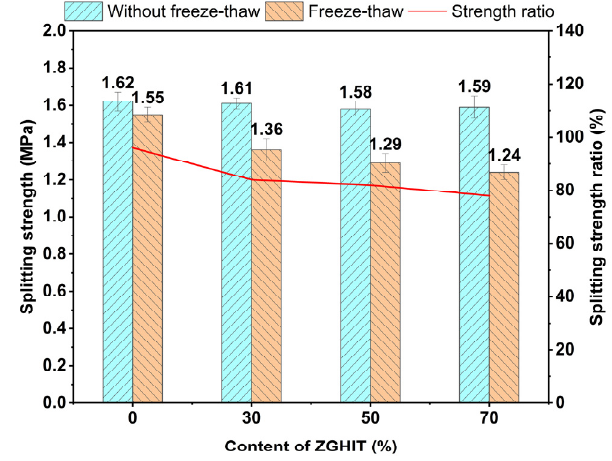
Figure 8. Results of the indirect tensile strength ratio test.